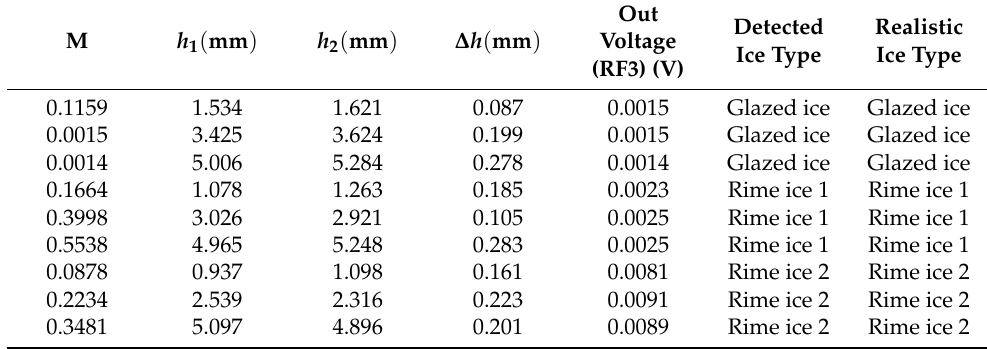
Table 5. Test data of ice sensor validation.